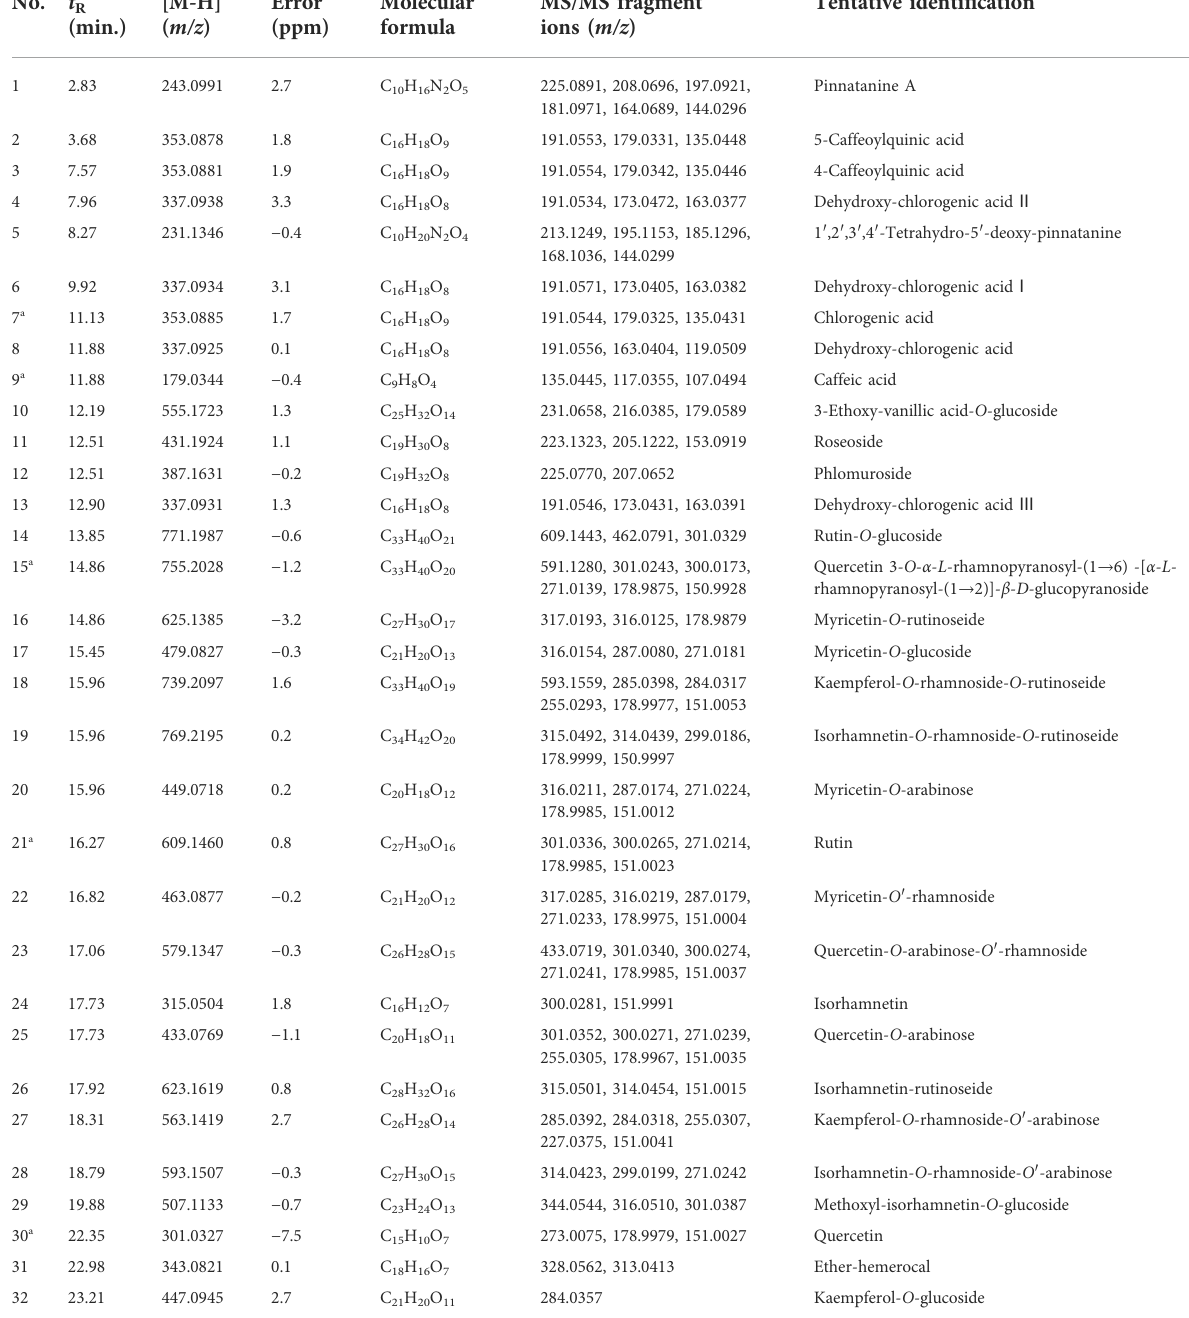
TABLE 1 Primary metabolites identi fi ed in HCW and HCE by HPLC-Q-TOF-MS. No. t R